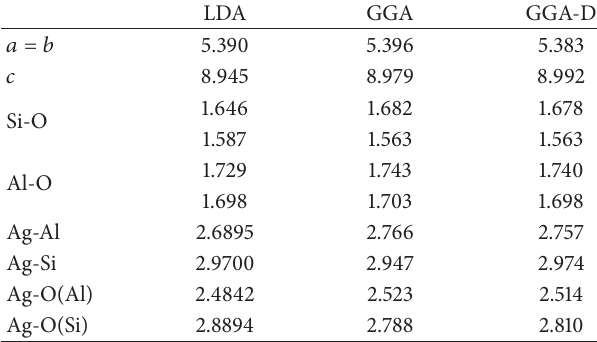
Figure 2: Relationship between adsorption energy ( 𝐸 𝑎 ) and the 𝑐 - axis coordinate ( 𝑥